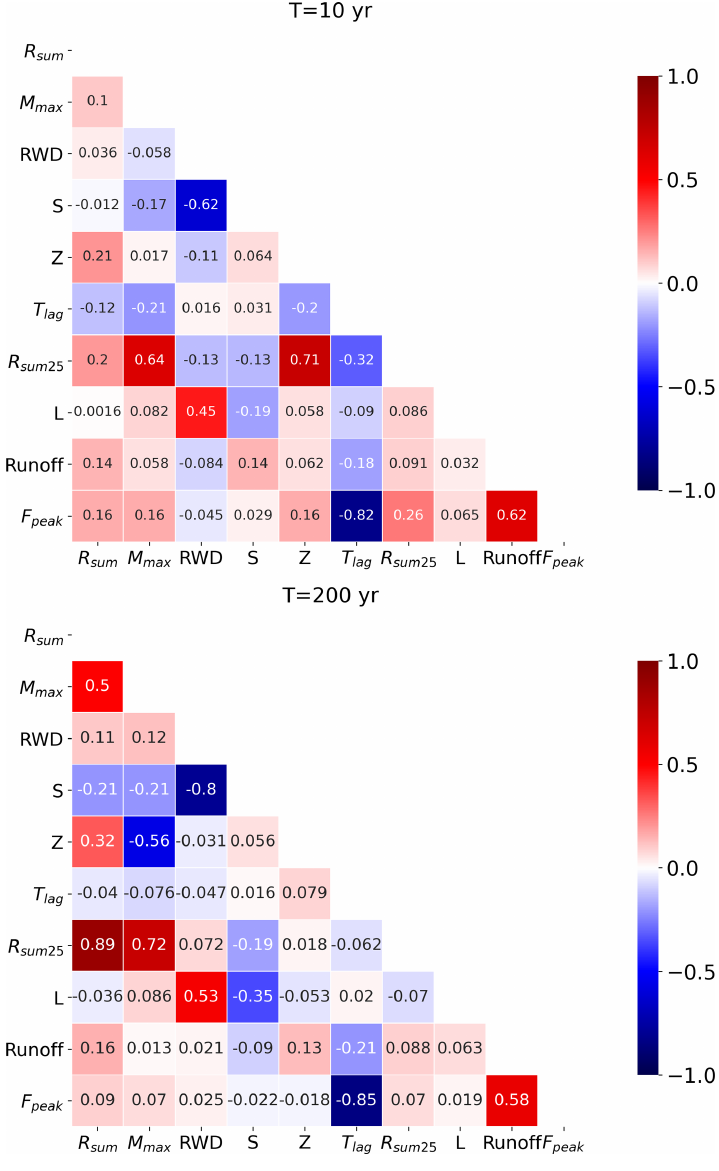
Figure A3. Correlation between space–time rainfall structure and flood responses at Franklintown under 10- and 200-year return periods.